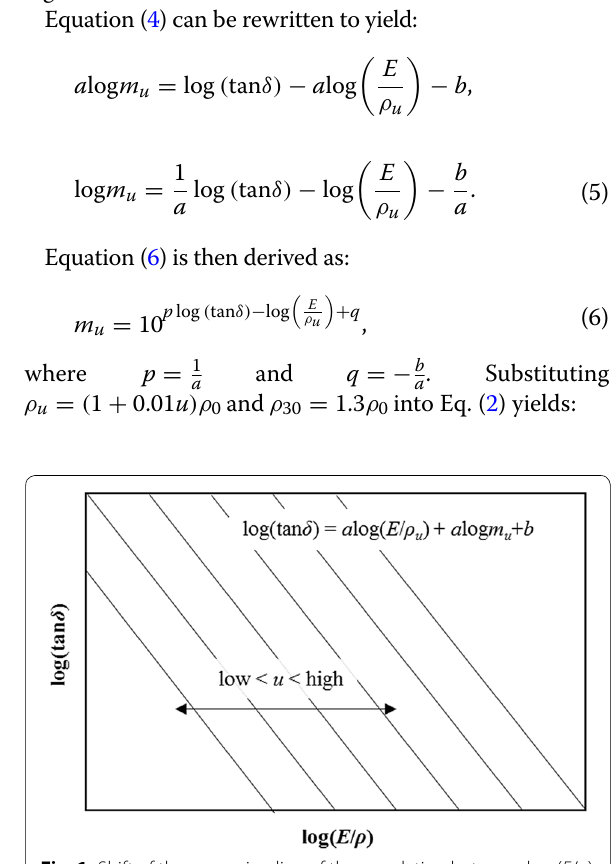
Fig. 1 Shift of the regression line of the correlation between log ( E / ρ ) and log (tan δ ) due to changes in the moisture content